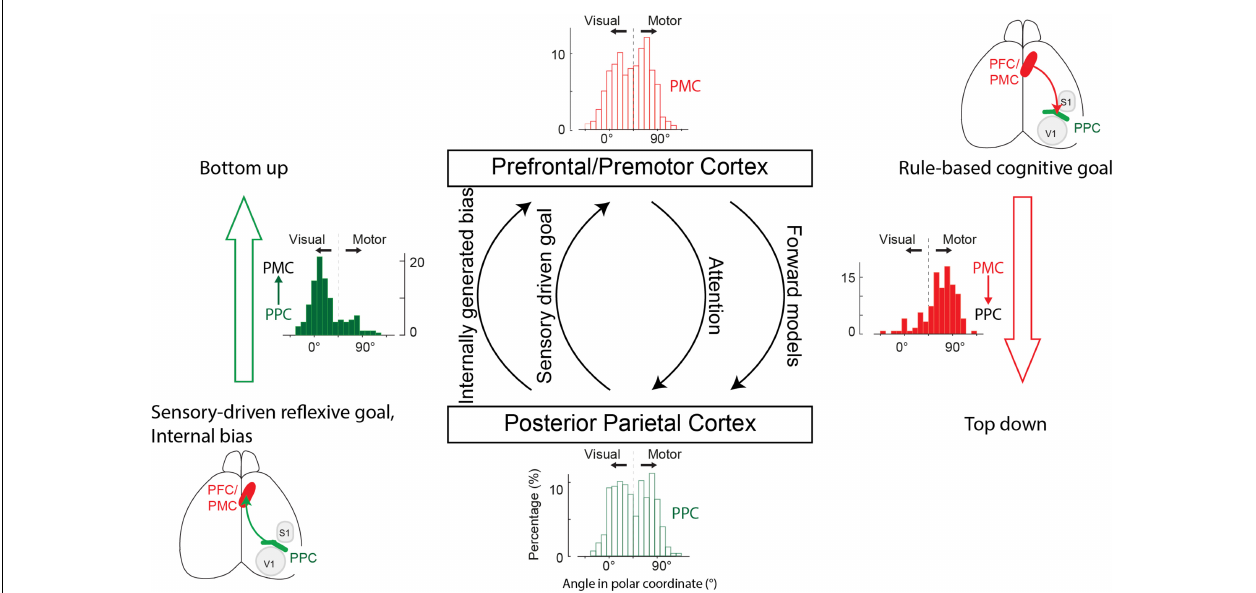
FIGURE 2 | Proposed parallel information flows between the PFC/PMC and the PPC. The PPC sends PFC/PMC sensory-driven or internally biased target information for planning eye, limb, and whole-body movements. The PFC/PMC sends the PPC motor target information required for processing attention, forward models, and multibody coordination in parallel. Histograms represent the degree of sensory- vs. motor-target coding across all neurons in the PPC (bottom), axons projecting from the PPC to the PMC (left), all neurons in the PMC (top), and axons projecting from the PMC to the PPC (right). Coding preference for individual neurons or axons was represented as a polar angle in a two-dimensional plane in which the x- and y -axes correspond to visual and motor activity in a visually guided eye movement task in mice (Itokazu et al., 2018). Zero degree means purely visual activity and 90 degrees means solely motor activity.